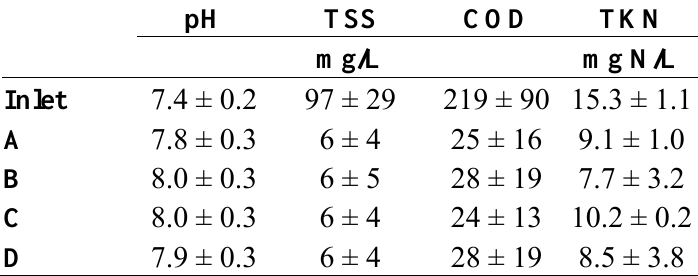
Table 2. Treatment performance observed during the reconstituted sludge fish farm effluent feeding step (Step